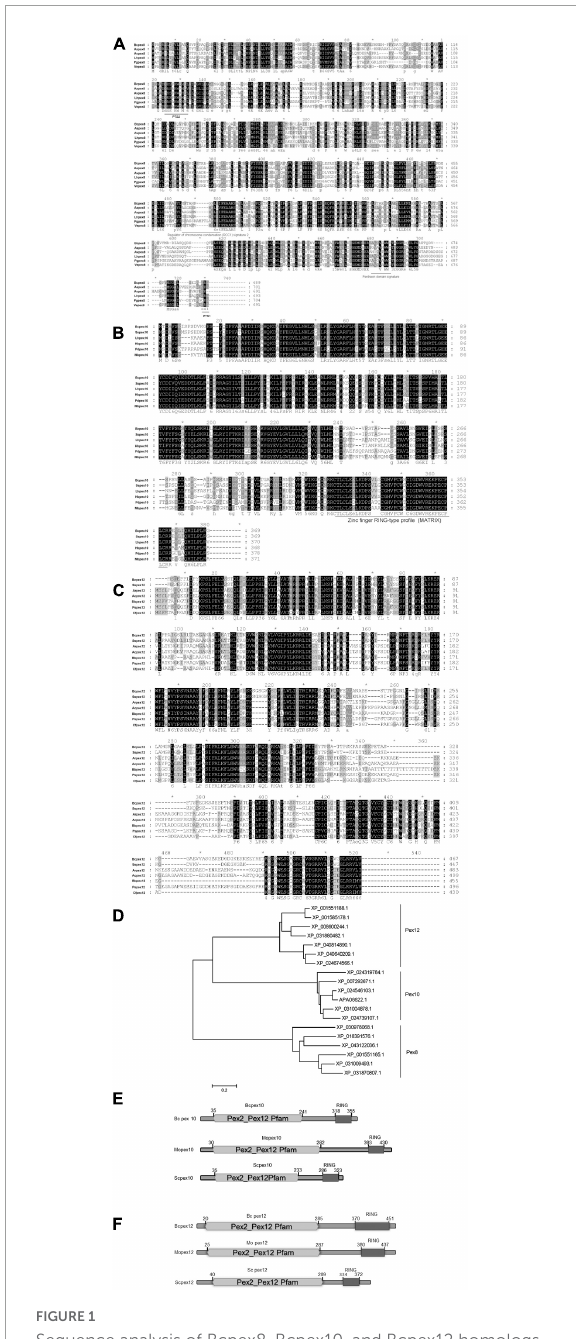
FIGURE1 Sequence analysis of Bcpex8, Bcpex10, and Bcpex12 homologs. Protein sequences of Mopex8 (A) , Mopex10 (B) , and Mopex12 (C) and the homologous proteins from other related fungal species were aligned using Clustal X method. The identical amino acids are highlighted against a black background, the conserved residues on a dark gray background and the similar residues on a light gray background. “*” indicates only the positions each 10 residues. (D) Phylogenetic relationship of Pex8, Pex10, and Pex12 homologs calculated using the neighbor-joining method with the MEGAX program according to the alignment. (E) Domain architectures of PEX10